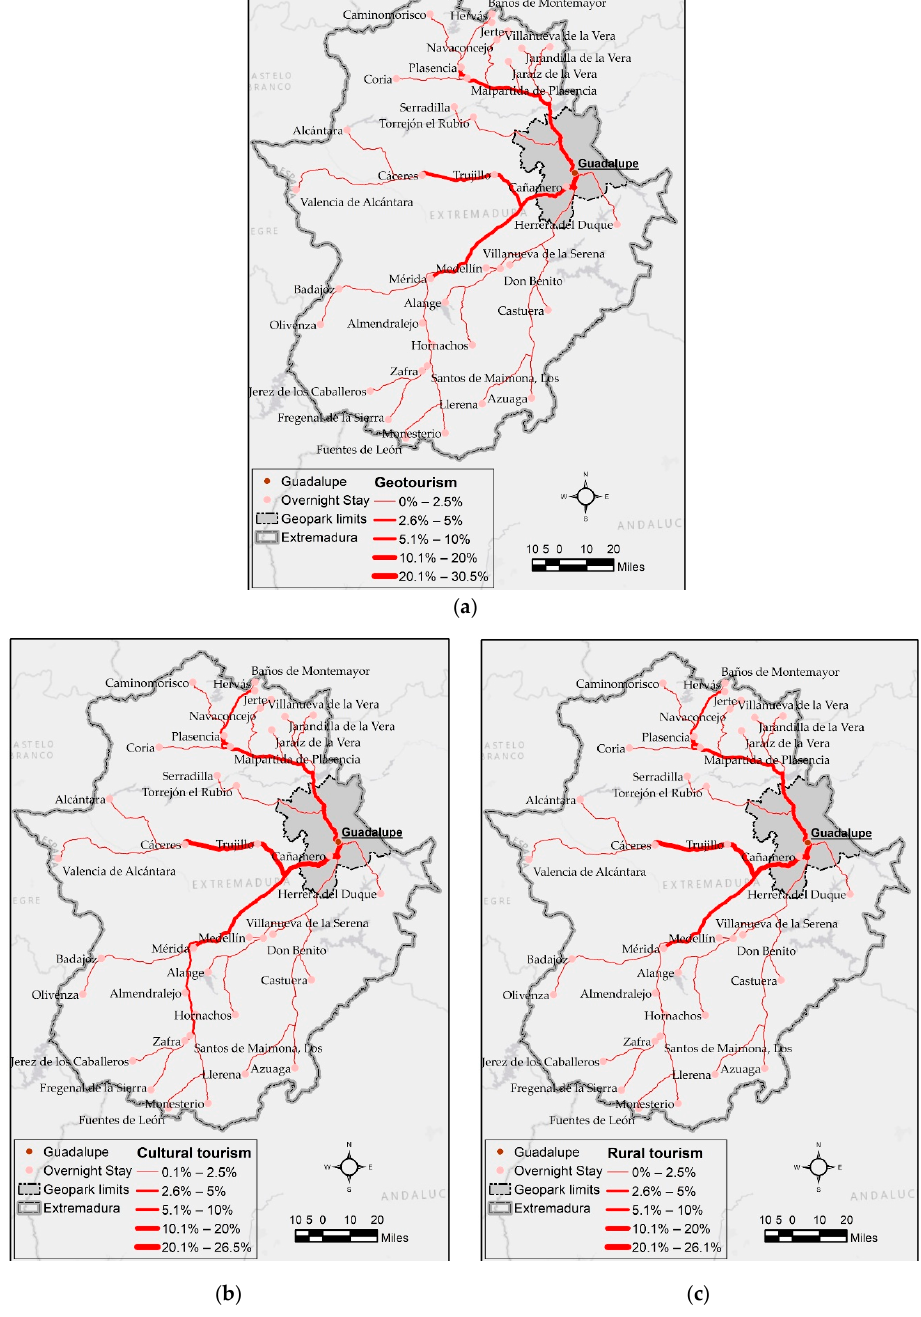
Figure 6. Attraction capacity of the geopark according to the motivations of the demand. ( a ) Geotourism; ( b ) Cultural tourism; ( c ) Rual tourism.